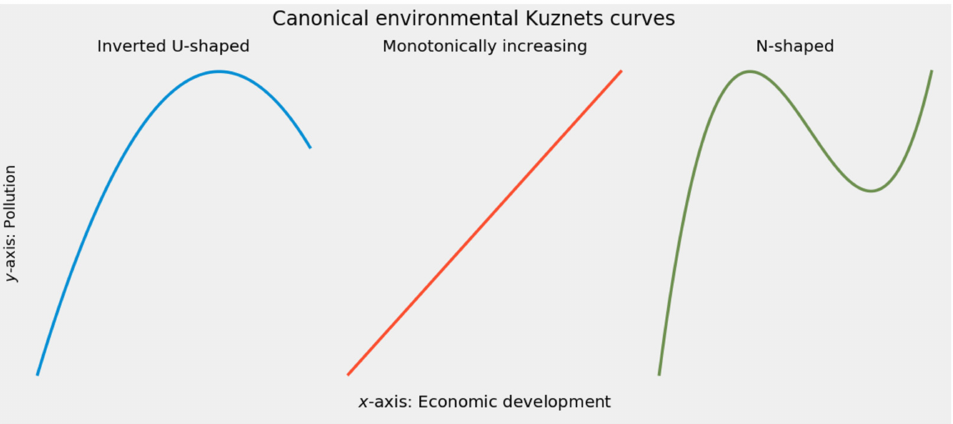
Figure 1. Canonical environmental Kuznets